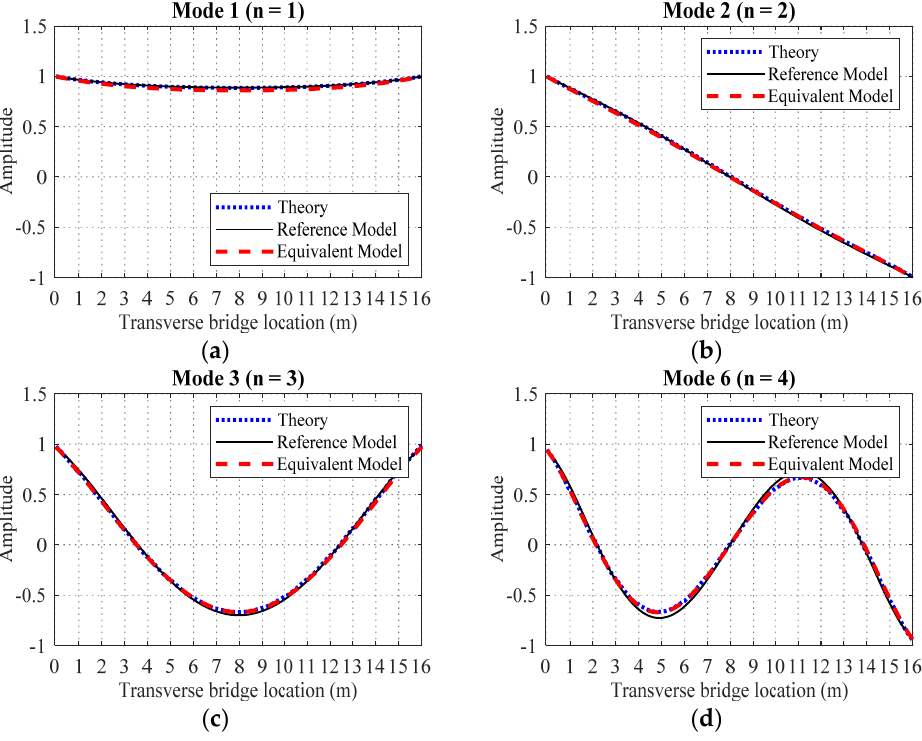
Figure 7. Transverse modal shapes comparison: ( a ) Mode 1, n = 1; ( b ) Mode 2, n = 2; ( c ) Mode 3, n = 3; ( d ) Mode 6, n = 4.